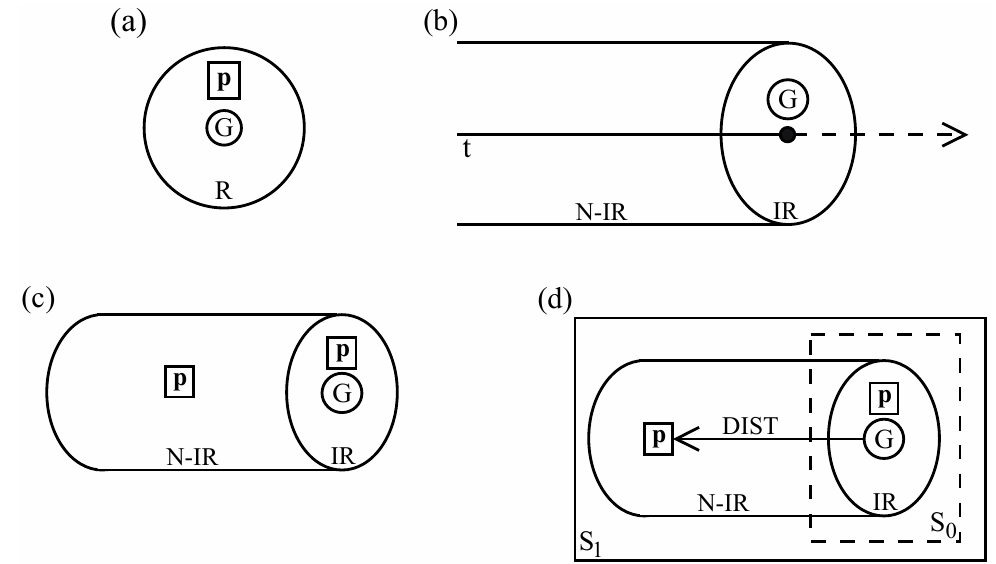
Figure 1. Grounding in baseline reality.